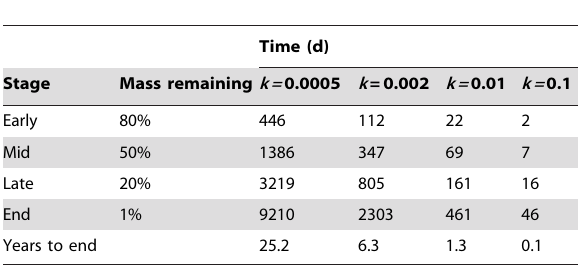
Table 1. Percent mass remaining at early, mid, late and end stage decomposition for four different decomposition rates ( k in d 2 1 ).